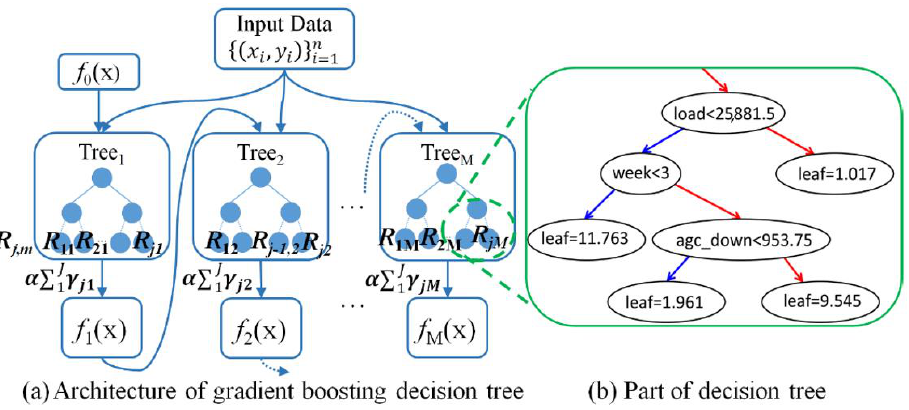
Figure 4. The architecture of GBDT for the CPS1 model: ( a ) Architecture of GBDT, ( b ) Part of decision tree.